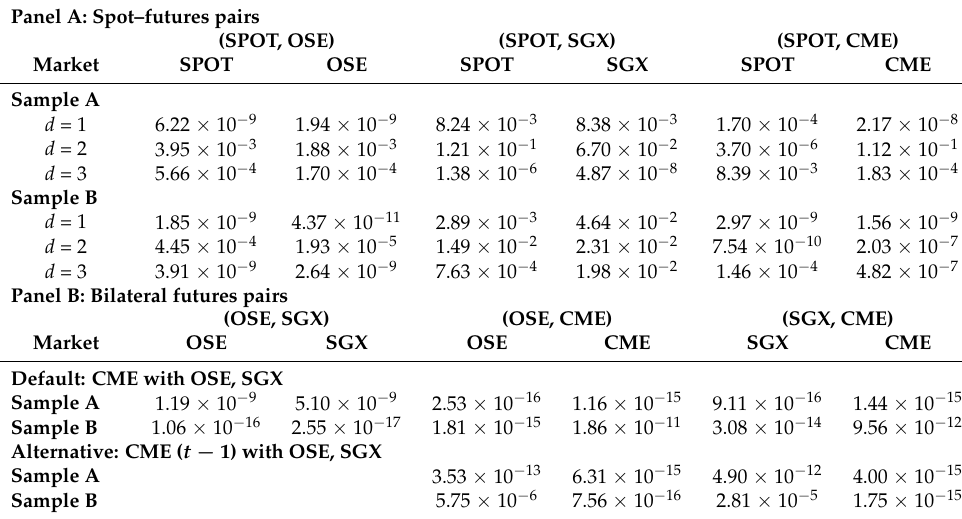
Table 2. LM-type linearity tests.